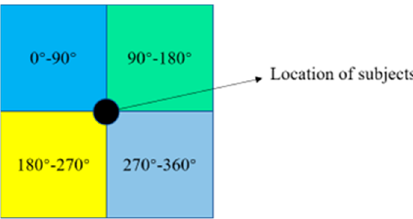
Figure 4. Area–division diagram.